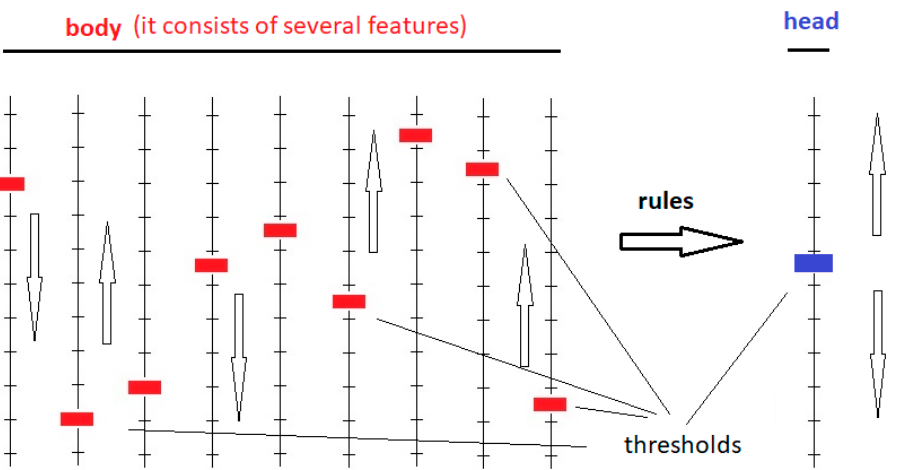
Figure 2. The problem: how to set the thresholds (red and blue) to allow finding the most powerful and most informative rules (if body then head) based on a specific